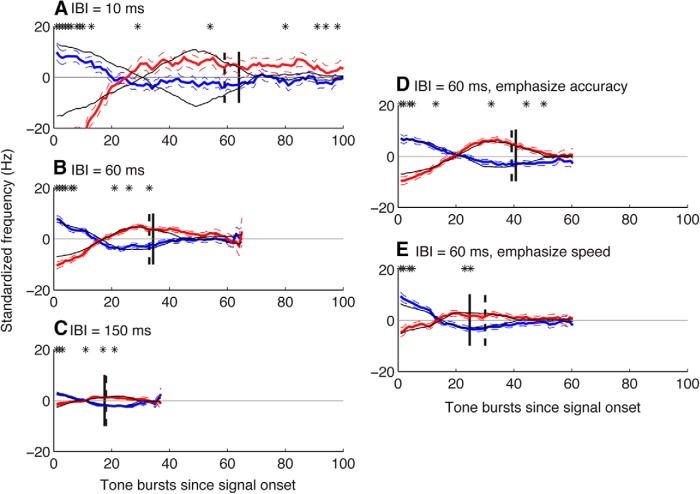
Psychophysical kernels. Kernels represent the average of the stimulus sequence (mean subtracted on each trial) presented on all 0%-coherence trials across subjects for increasing (red) and decreasing (blue) choices. A−C, Kernels computed per IBI condition, as indicated, and smoothed using a 21-sample moving mean. D, E, Kernels for the 60 ms IBI condition when subjects were told to emphasize accuracy or speed, respectively. Thick and broken lines are mean and standard error, respectively. Data are aligned relative to onset of the sequence. Asterisks indicate that the increasing and decreasing kernels were significantly different from one another for a given time bin (Mann−Whitney test, p < 0.05p, using the raw, unsmoothed kernels). Black lines indicate best-fitting simulated kernels (see text for details). Solid vertical lines indicate median RT. Dashed vertical lines indicate the end of the integration time from the best-fitting simulated kernels.